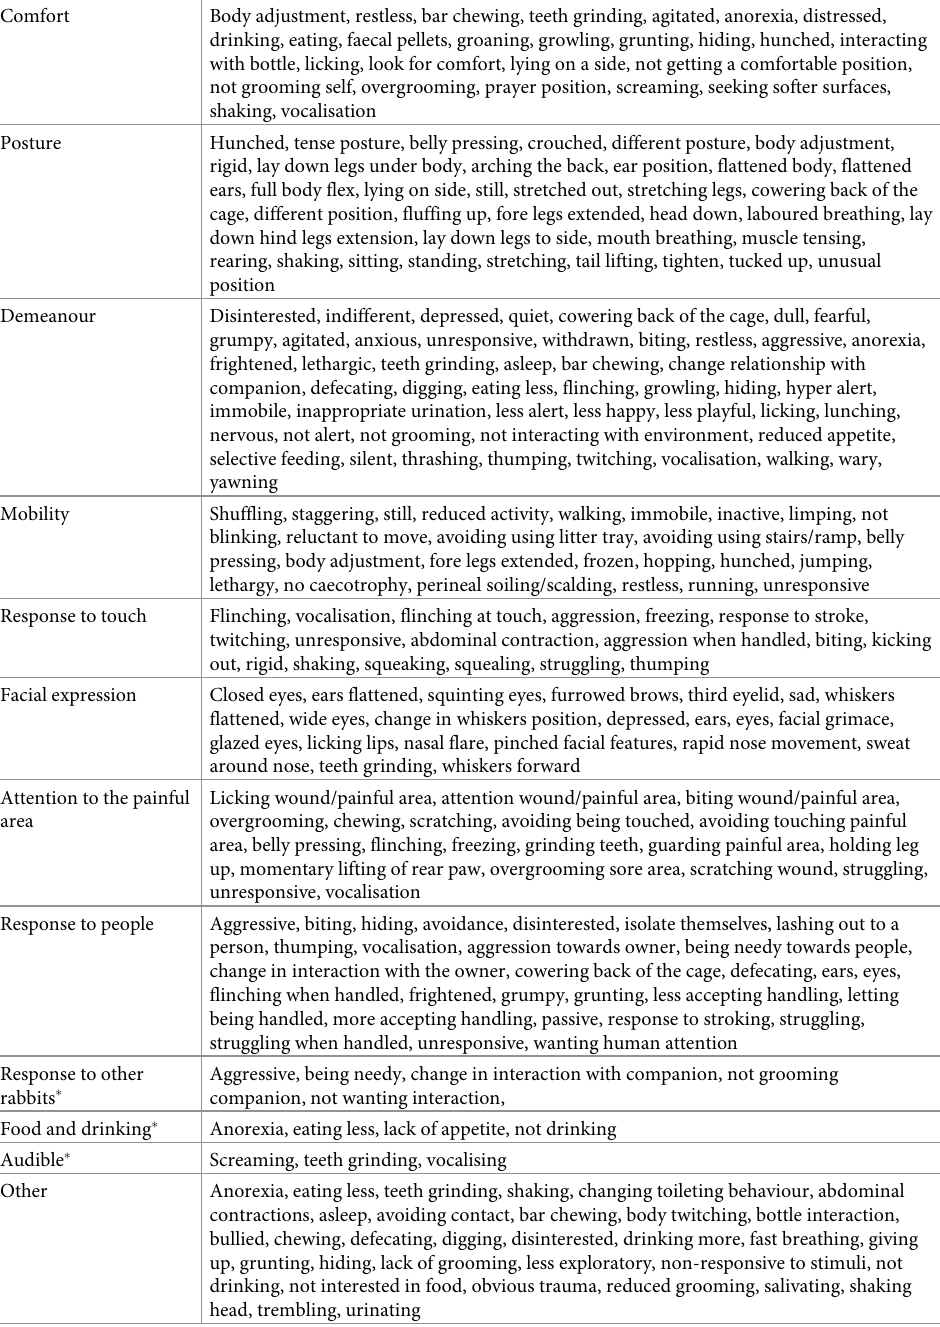
Table 1. Categories and descriptors collected during the nine focus groups in phase one of the study. Nine catego- ries were provided (Posture, Comfort, Demeanour, Mobility, Response to touch, Facial expression, Attention to the painful area, Response to people, and Other) and three new categories were added by the participants (Response to other rabbits, Food and drinking, and Audible) � . Some descriptors were reported in more than one